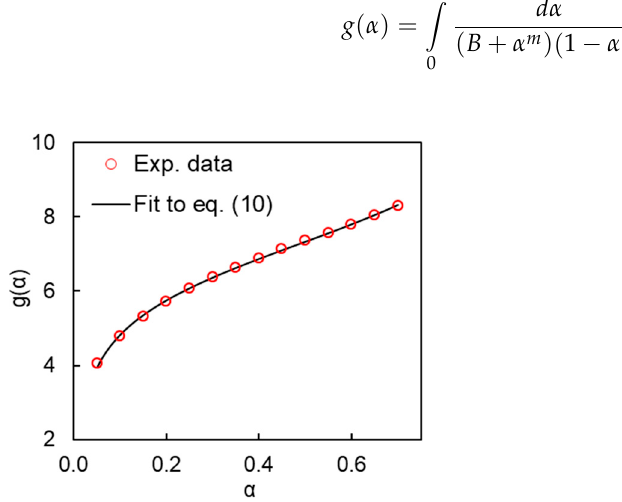
Figure 8. Fitting experimental g ( α ) data for polymerization of cyanate